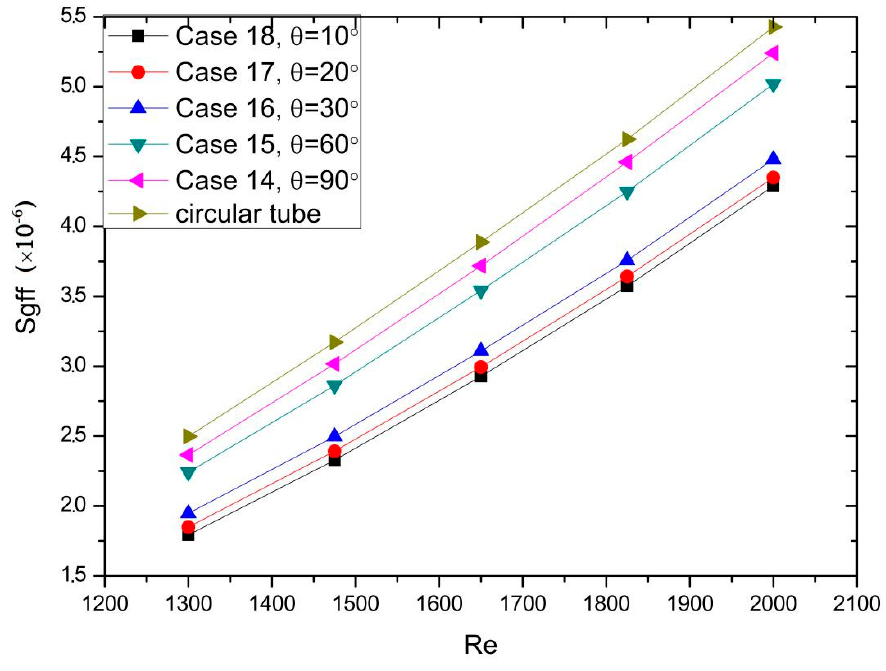
Figure 11. E ff ect of di ff erent angle on Sg ff at di ff erent Reynolds numbers. Figure 11. Effect of different angle on Sgff at different Reynolds numbers. Figure 11. Effect of different angle on Sgff at different Reynolds numbers.